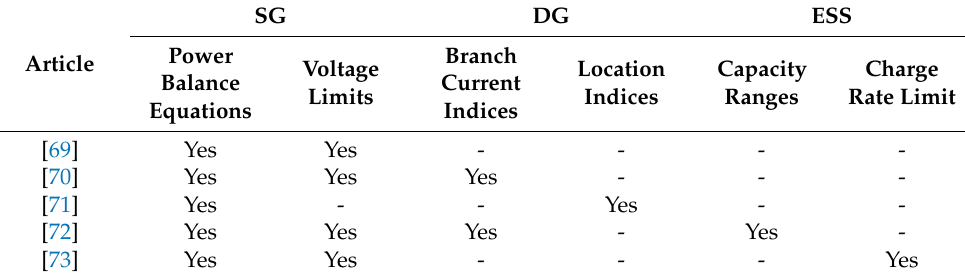
Table 3. Considerations of constraints for optimization